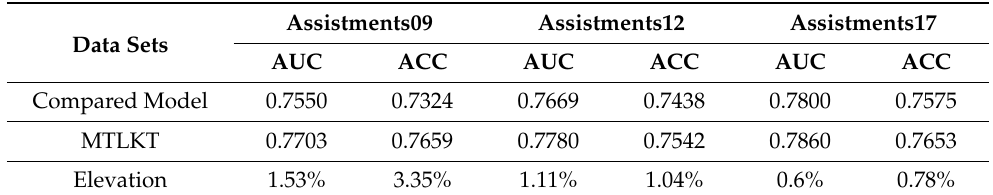
Table 7. Information difficulty extraction module ablation